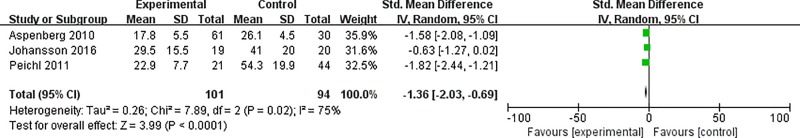
Forest plot for radiological fracture functional outcome.